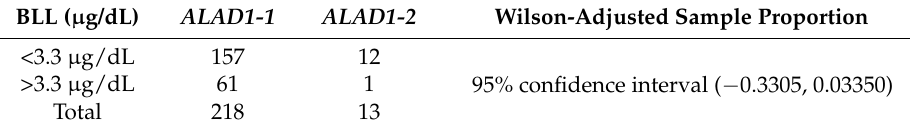
Table 2. Wilson-adjusted sample proportion to determine association between ALAD1-1 , ALAD1-2 and blood lead levels. Though results are consistent with decreased blood lead levels among those with the ALAD-2 allele, the numbers are too small to produce a statistically significant